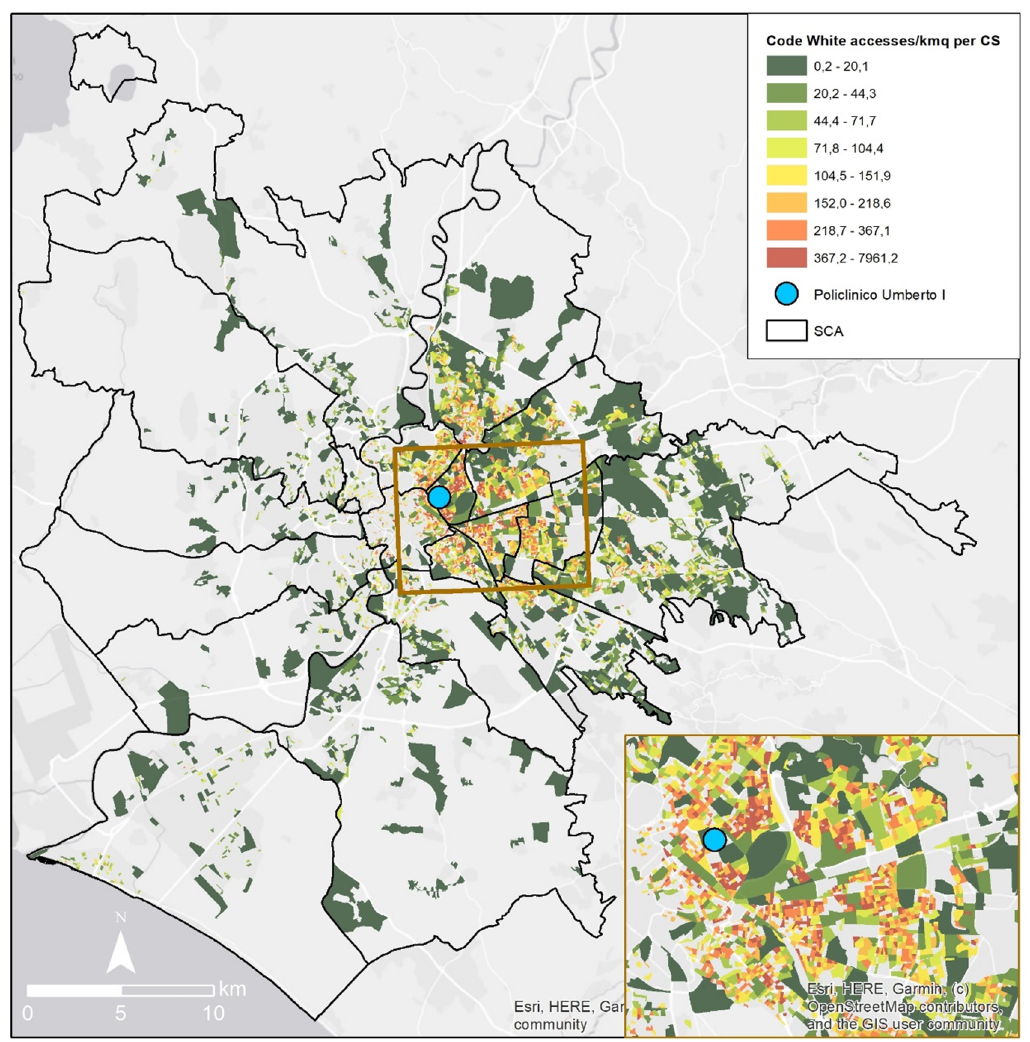
Figure 9. Accesses in code white recorded by the Policlinico Umberto I emergency room in relation to the surface, with data aggregated on the basis of census sections. Source: authors’ elaboration.